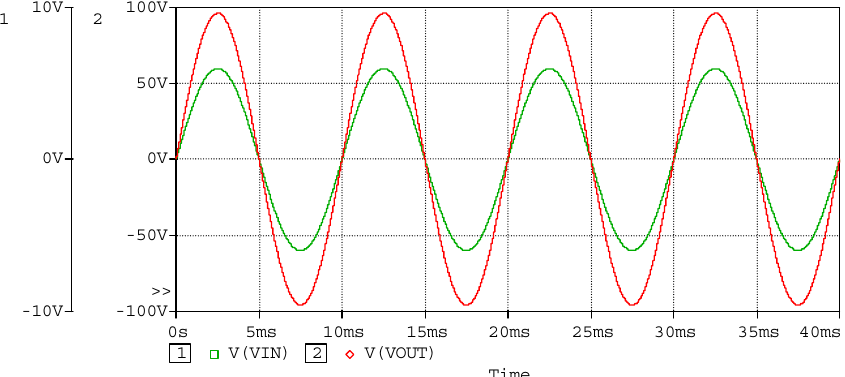
Figure 12. Simulated waveforms of input and output, as the input sinusoidal wave has amplitude of 6 V and frequency of 100 Hz.